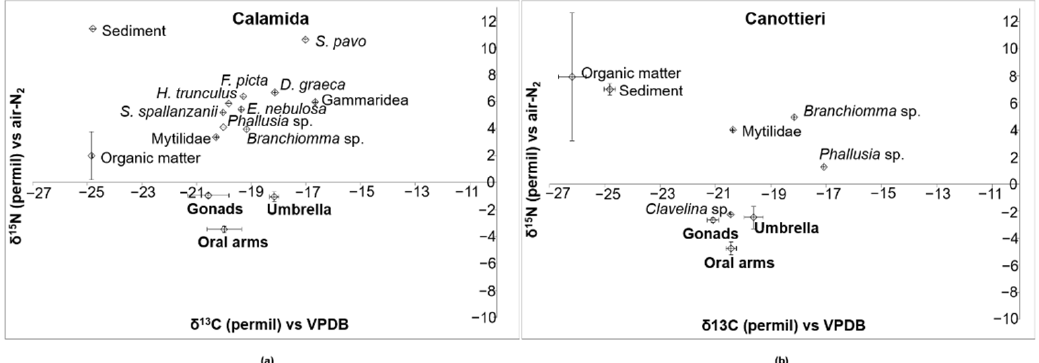
Figure 14. Bidimensional plot of δ 15 N versus δ 13 C (average ± S.E. as vertical bar) in the gonads, oral arms, and umbrella of Cassiopea andromeda individuals; sediments, organic matter, and some benthic organisms ( Branchiomma sp.; Clavelina sp.; Diodora graeca ; Eupolymnia nebulosa ; Felimare picta ; Gammaridea; Hexaplex trunculus ; Mytilidae; Phallusia sp.; Salaria pavo ; and Sabella spallanzanii ) collected from two sites of Cala: ( a ) Calamida and ( b ) Canottieri.